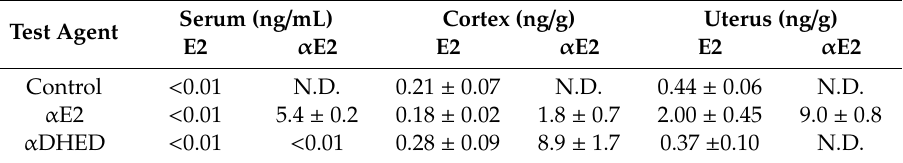
Figure 8. Immobility times and wet uterus weights after the s.c. administration (5 days, once daily) of increasing doses of ( A ) α E2 and ( B ) α DHED to OVX CD1 mice. Data are expressed as mean ± SD, n = 6, except for vehicle control group ( n = 12). Asterisk (*) denotes statistically significant di ff erence from control (one-way ANOVA followed by post hoc Dunnett’s tests); e ff ect size of behavioral response is indicated by Cohen’s d. Adopted with permission from reference [37]; copyright American Chemical Society. Table 1. Estrogen concentrations in blood, cortex and uterus after s.c. treatment of OVX CD1 mice ( n = 4) for 5 days, once daily with vehicle (control), α E2 (300 µ g / kg body weight) and α -DHED (300 µ g / kg body weight), respectively. Errors are given as SEM. Adopted with permission from reference [37]; copyright American Chemical